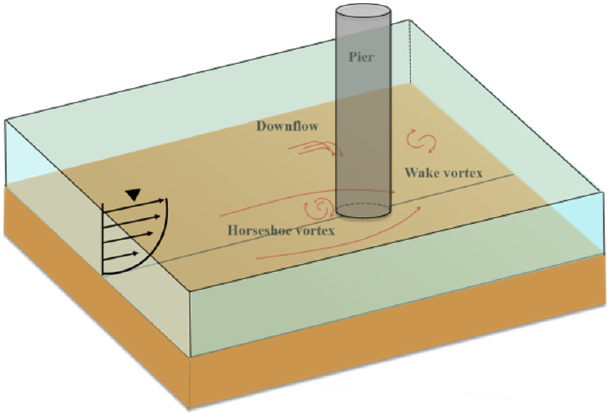
Figure 1. Sketch of flow pattern around the pier.